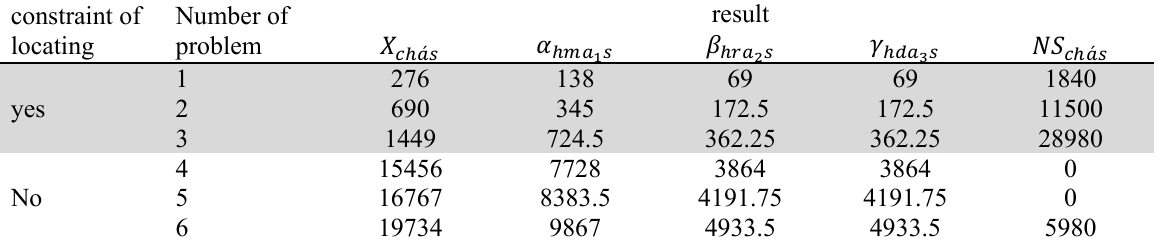
Results of deterministic model that solved by GAMS in randomly generated test problems constraint of Number locating